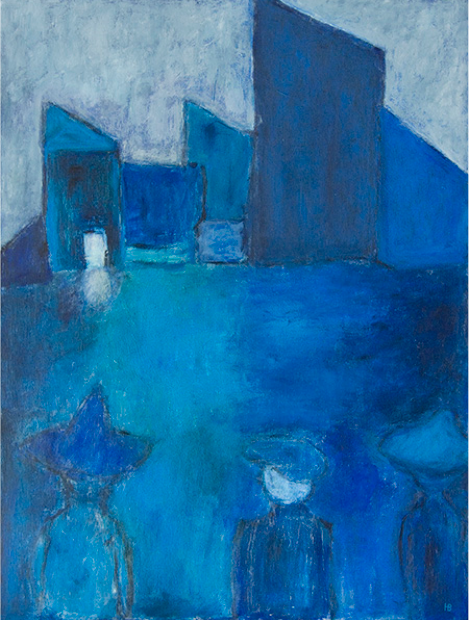
Figure 6. Hannah Bischof, “ Die drei Besucher ”, acrylic on canvas, Berlin 2012, © Ben Bischof. In the next work, “ Innenhof mit dunklem Bett ” (“Inner courtyard with dark bed”), Maria is transferred to the state institution in Neuruppin, Brandenburg, on 14 August 1941. This transfer is her death sentence: she will either starve to death, be given a lethal injection, or be taken by a grey bus to an Aktion T4 killing center. With her bed in the middle of the courtyard, surrounded by sharp, intimidating, coldly-colored houses, she becomes almost an object. She is alone, surrounded by an enormous, empty space: there are no other people, no other voices, and no one can understand her condition.